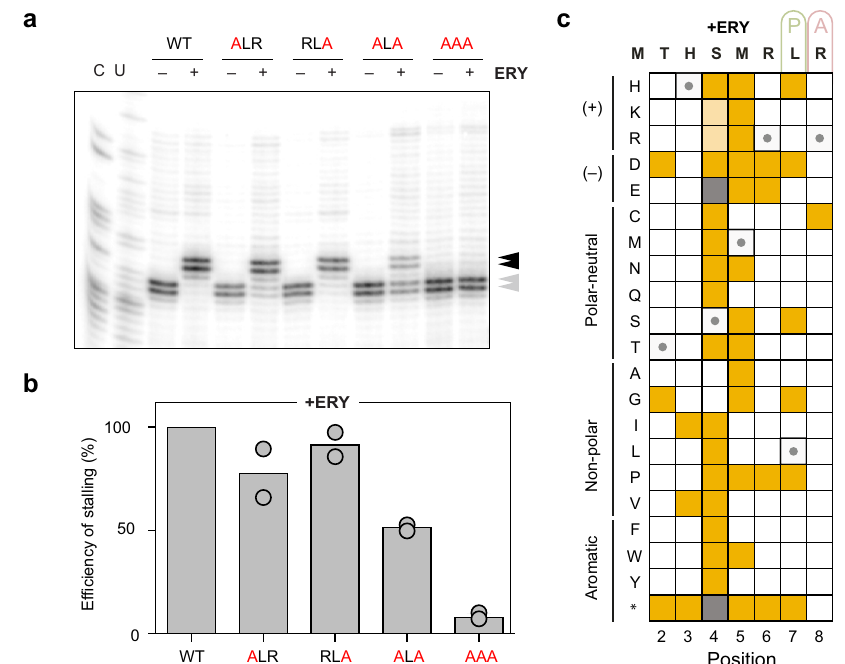
Fig. 4 Sequence dependence of ErmDL arrest in the response to ERY. a The RLR motif of ermDL is not critical for ribosomes stalling with ERY. Toeprinting assay to assess translation arrest at ermDL sequences, with the original RLR motif (wt) or containing Ala mutations, in the presence of ERY. The toeprint bands of ERY stalled ribosomes at codon 7 (Leu or Ala) is indicated by a black arrow; the bands from ribosomes arrested at codon 8 because of the presence of mupirocin (see legend of Fig. 1d) are shown with gray arrows. Sequencing reaction lanes are labeled with C and U. b Ef fi ciency of ribosome stalling with ERY estimated as described in the legend of Fig. 1d. Circles represent the values from two independent experiments, whereas the bar represents the mean value. c Sequence-function map for seven positions of the ErmDL peptide translated in the presence of ERY, where mutations that abolish arrest (score < − 1.5) are shown in yellow, as described in Supplementary Fig. 1. The ribosomal P (green) and A (pink) sites are indicated above the wild-type ErmDL sequence. Variants in gray were not measured and cells marked with a circle correspond to the wild-type amino acid. Mutations S4K and S4R lead to the appearance of a (K/R)MR arrest motif at position 4 that prevents the synthesis of the full peptide and leads to spuriously low scores for these two